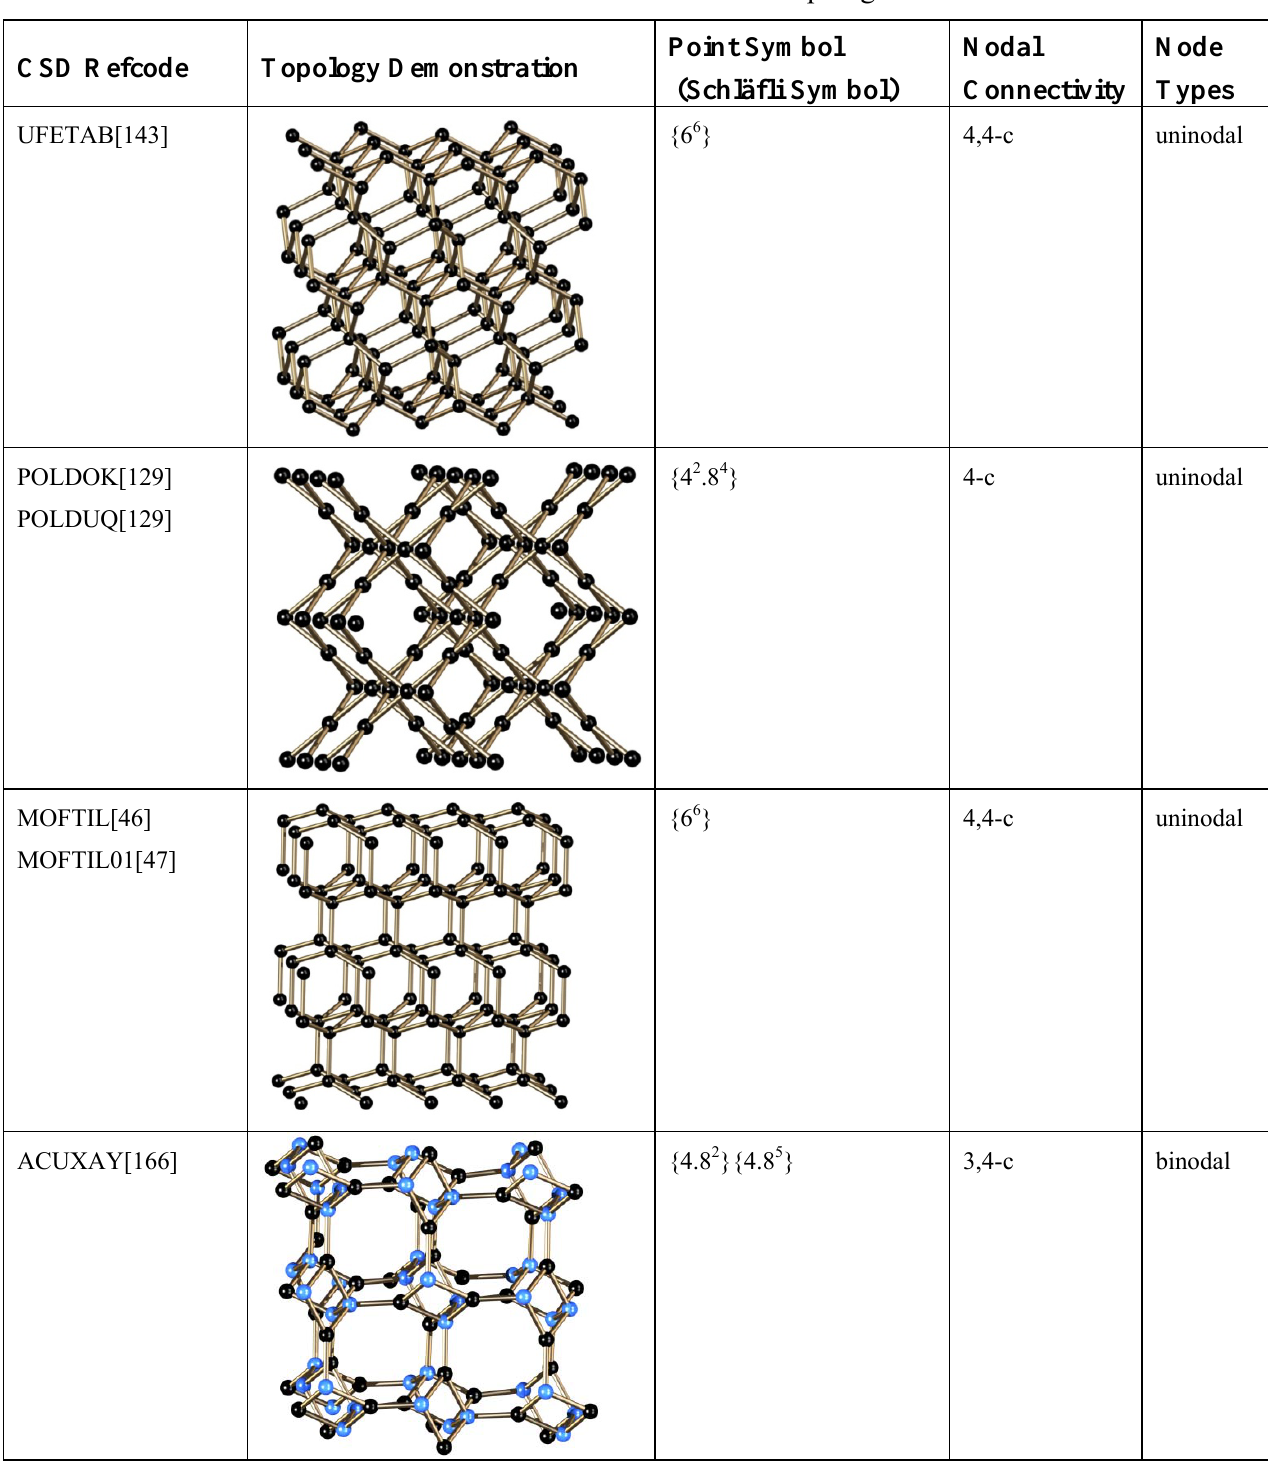
Table 2. New Three-Dimensional